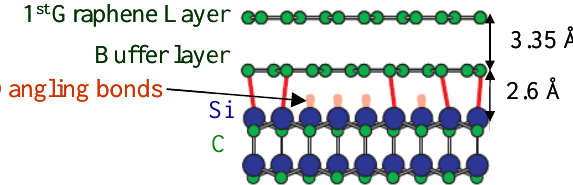
Figure 1. Illustration of the structure of monolayer EG grown on SiC (0001), showing the buffer layer partially bond to the Si face, with unsaturated dangling bonds at the interface.